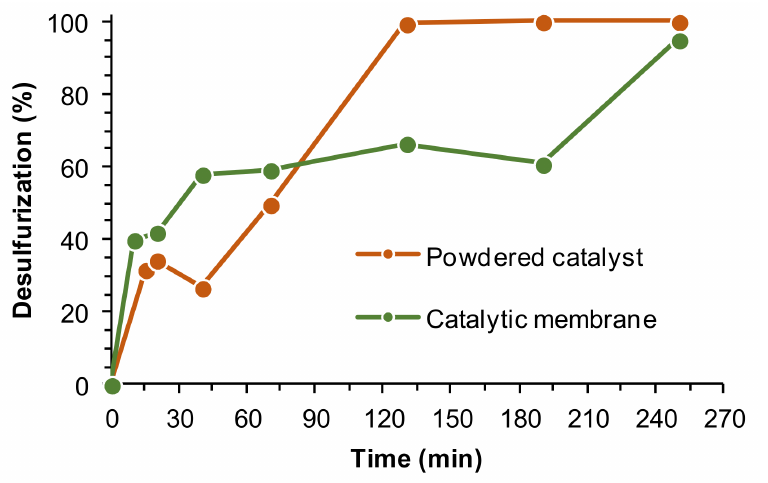
Figure 5. Desulfurization of a multicomponent model diesel catalyzed by the UAV-59 catalyst as a powder and as the UAV-59@PMMA membrane (both catalysts containing 0.04 mmol of Gd 3+ ), using H 2 O 2 as oxidant (0.64 mmol) and [BMIM]PF 6 as the extraction solvent (1:1 diesel:solvent), at 70 ◦ C. The lines connecting experimental points are only for guidance.